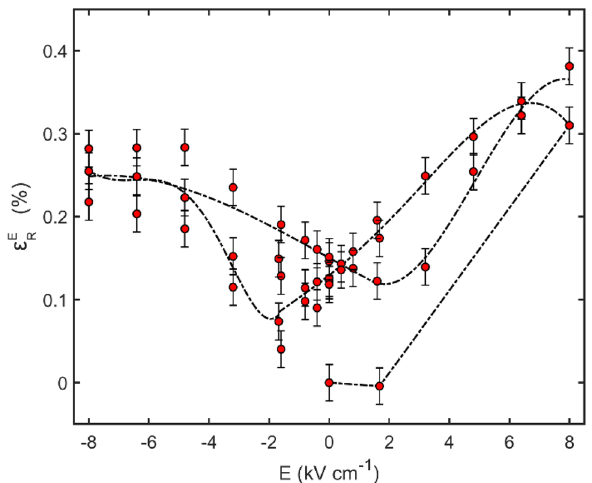
E Figure 2. The perpendicular strain ε R ( E ) in the rhombohedral phase of PMN-PT is plotted against applied electric field E . The data demonstrate a large, butterfly-like piezoelectric response, with the strain reaching a maximum of 0.38% at E = 8 kV cm −1 . The dashed curve is a guide-to-the-eye constructed by stitching polynomial fits to the